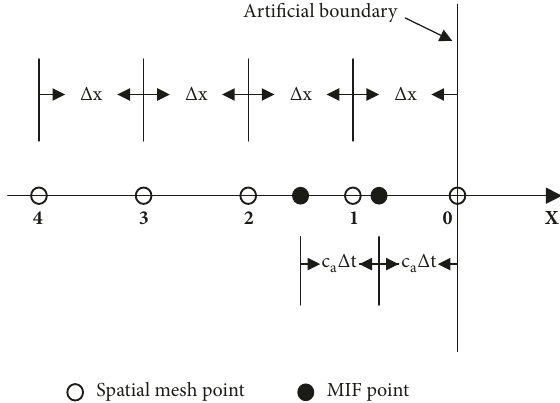
Figure 2: Arrangement of the spatial mesh points and the compu- tational points on the right artificial